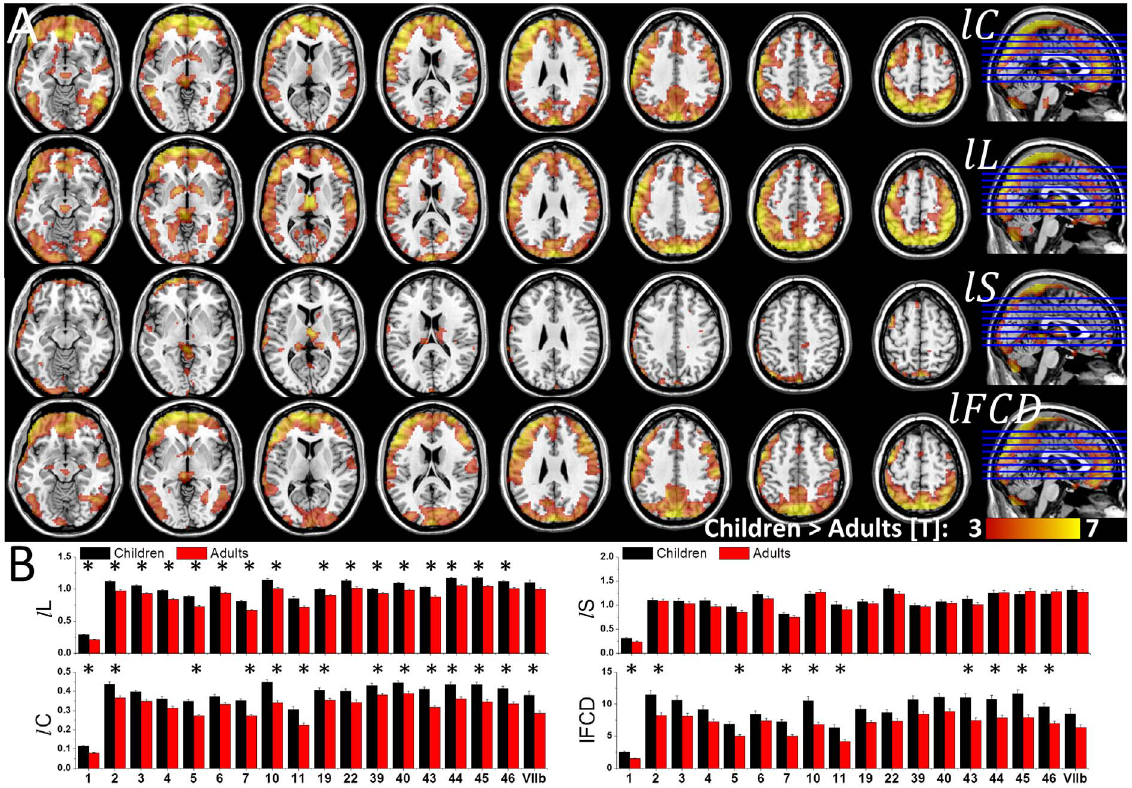
Figure 6. Pruning of functional connectivity during brain maturation. (A) Statistical significance of higher graph theory measures for 40 children than for 74 adults superimposed on axial views of the human brain. (B) Average values of the graph theory measures in anatomical ROI that demonstrated significant differences in the measures between children and adults. X-axis labels: Brodmann Areas (number labels), thalamus (THA), putamen (PUT), globus pallidus (GP), amygdala (AMY) and the posterior lobe of the cerebellum (lobe X). Correlation thresholds: R T1 = 0. 50; R T2 = 0.65.